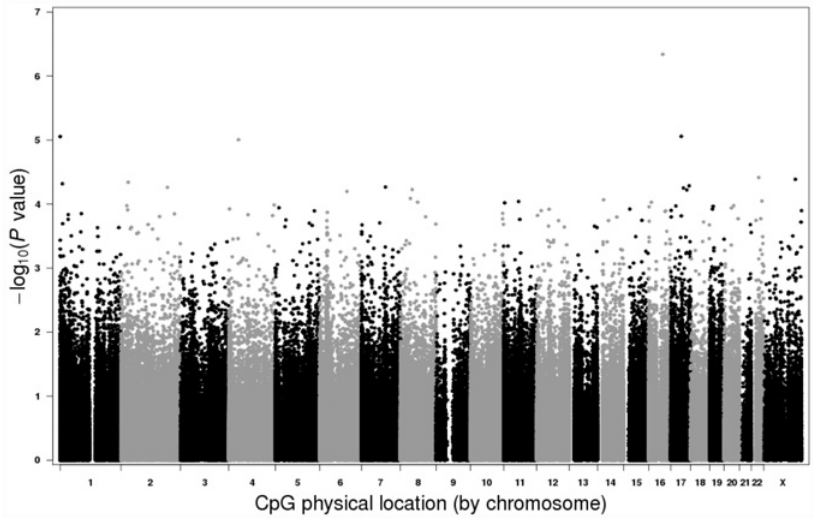
CpGs in the genome). Limitations include lack of detailed information on dose, route of expo- sure, timing, or duration of DES use. Additionally we had limited power to detect small effect sizes (defined by the absolute methylation difference between two groups, divided by the stan- dard deviation). With a sample size of 200 (1:1 case/control ratio) and assuming a p-value threshold of 10 -8 , our study had 80% power to detect CpG sites with effect sizes of at least 0.67. The average effect size of our top 4 CpG sites was 0.5, which would require a study sample size of 354 to obtain 80% power. In this study we used DNA from blood rather than from a known target tissue such as vagi- na, cervix or endometrium. Histologic changes in target tissues, including vaginal epithelium,